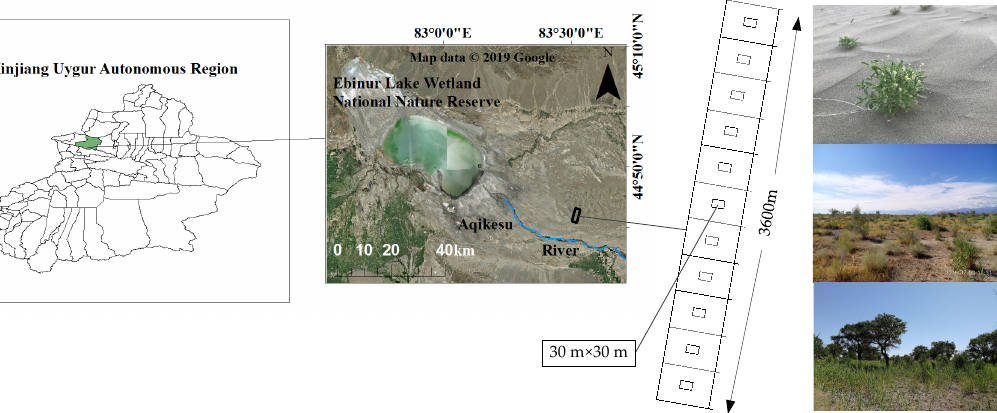
Figure 1. Research area and survey plot overview. Note: Photo shows changes in vegetation vertical to the Aqikesu River from near to far.